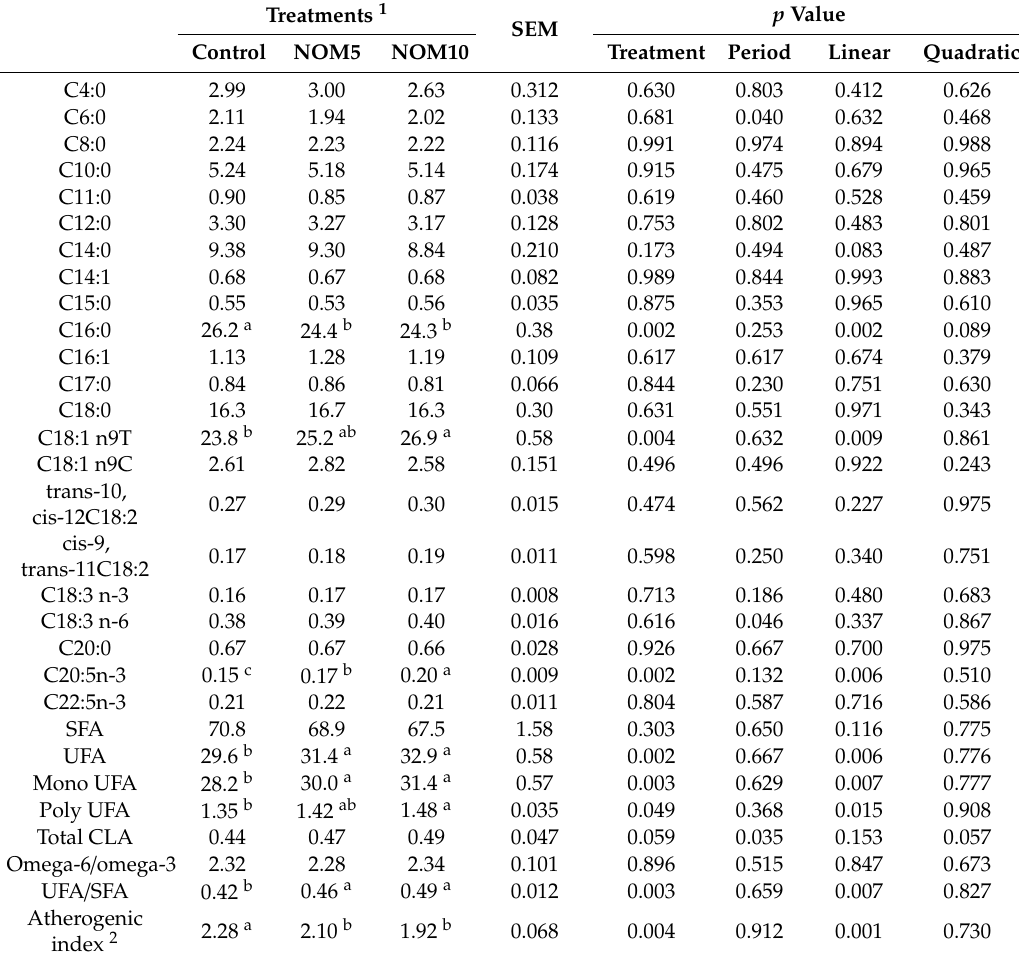
Table 4. Fatty acids profile (g / 100 g total fatty acids) in milk of lactating Nubian goats fed a basal diet supplemented with N. oculata